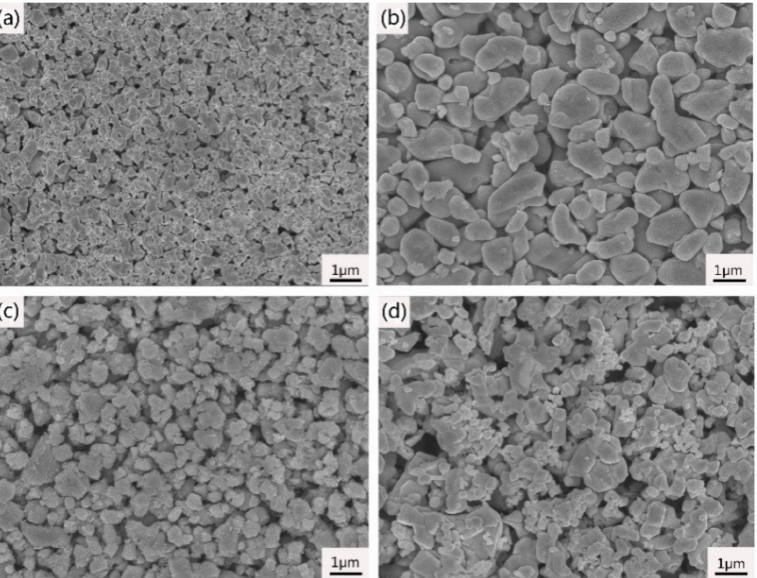
Figure 1. Scanning electron microscope (SEM) images of ( a ) WC; ( b ) Cr 3 C 2 ; ( c ) VC and ( d ) TaC raw